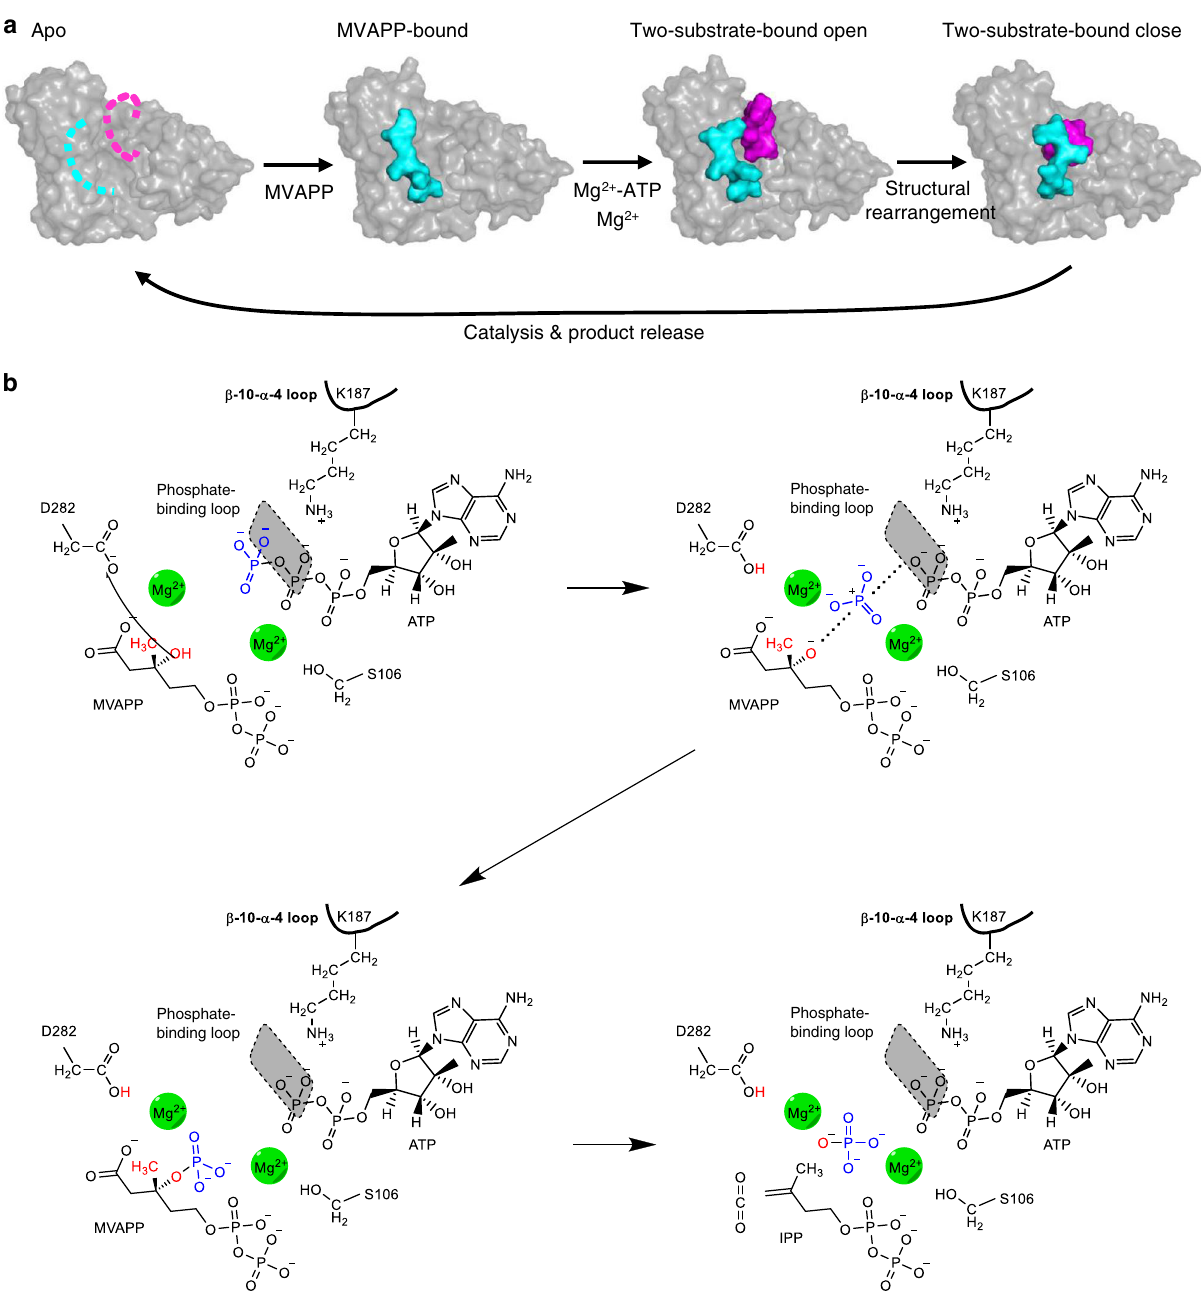
Fig. 7 Proposed model for the detailed MDD enzyme mechanism. a Changes in the MDD EF structure upon substrate binding. Left: unbound MDD EF . Middle-left: MVAPP-bound MDD EF ; the β 10- α 4 loop is presented as cyan surface. Middle-right: an open conformation of MDD EF bound with MVAPP and ATP; the β 10- α 4 loop and the phosphate-binding loop are shown in cyan and magenta surfaces. Right: a closed conformation of MDD EF bound with both substrates after conformational rearrangement; the β 10- α 4 loop and the phosphate-binding loop are shown in cyan and magenta surfaces. Enzyme catalysis occurs after these two loops close the active site entrance, followed by product release (isopentenyl diphosphate (IPP), ADP, CO 2 , and phosphate). b Dissociative phosphoryl transfer mechanism of MDD EF during enzyme catalysis. Top-left: D282 is orienting the 3 ′ -OH group of MVAPP (red). Top-right: dissociative phosphoryl transfer occurs and the metaphosphate (blue) is produced. Bottom-left: the metaphosphate attaches to the 3 ′ oxygen (red) of MVAPP and the proton is transferred to the transferred phosphate group. Bottom-right: dephosphorylation and decarboxylation occur and produce products, IPP, ADP, phosphate, and CO 2 . K187 from the β 10- α 4 loop and metal ions in the active site are involved in neutralizing the negatively charged environment and assist catalysis. The phosphate-binding loop (shown as a gray shadow as it is in a plane above the rest of the fi gure) is involved in the ATP binding in the closed form of the MDD EF